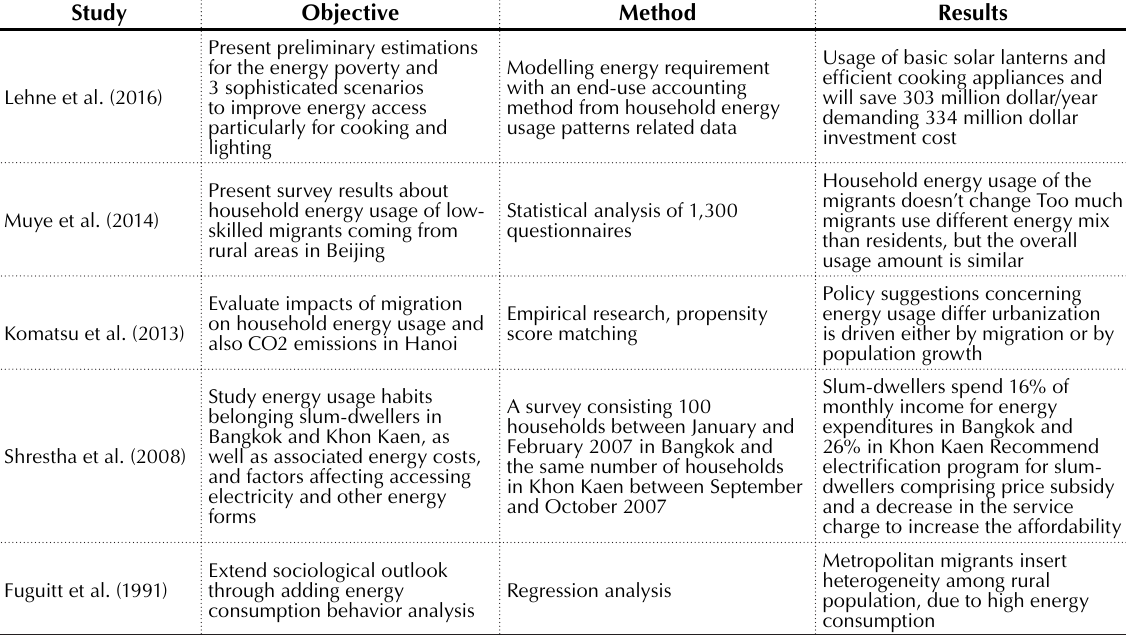
Table 4. Summary of energy consumption behaviors studies concerning migrated/displaced